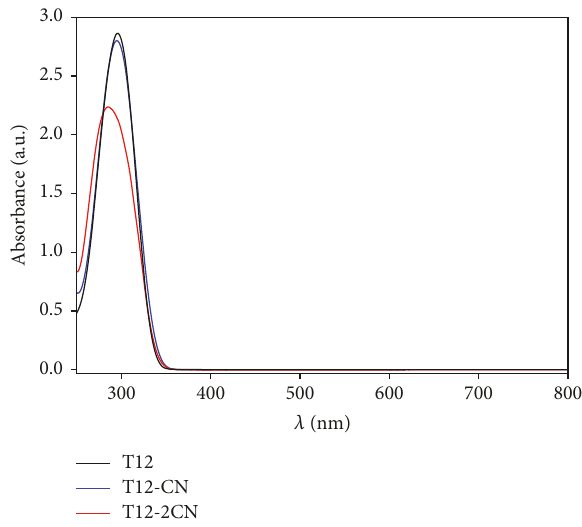
Figure 6: UV-Vis absorption spectra of